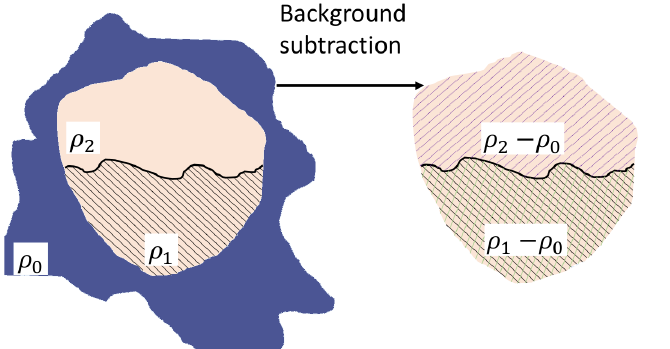
Figure 1. (Color online) Schematic representation of the background subtraction procedure. (Left) A three-phase system consisting from a particle of arbitrarily shape having two regions of different SLD ρ 1 and ρ 2 , embedded in a matrix with SLD ρ 0 . (Right) The corresponding two-phase system after subtracting the matrix background consists from the same regions but with SLD ρ 2 − ρ 0 and ρ 1 − ρ 0 ,